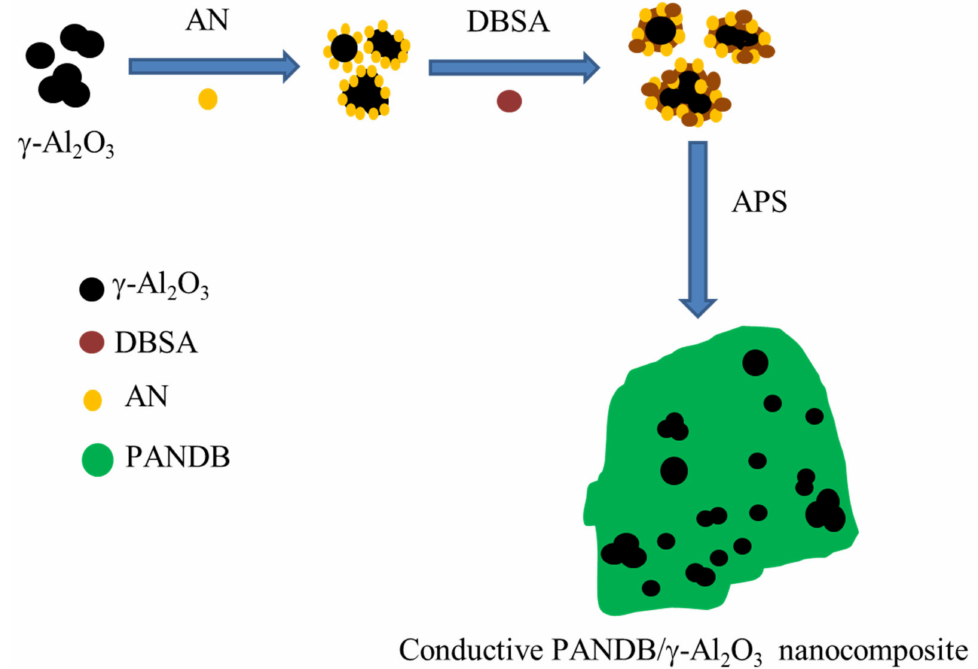
Figure 7. Synthesis process of conductive PANDB/ γ -Al 2 O 3 core–shell nanocomposites through in situ